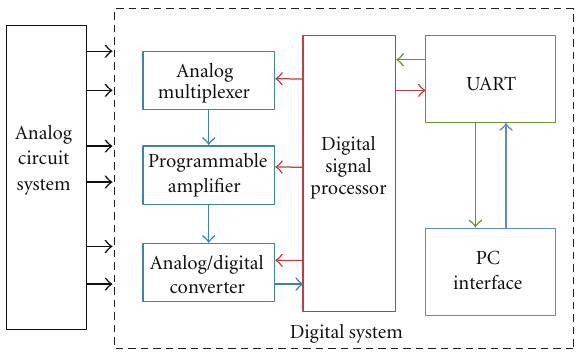
Figure 4: Digital system